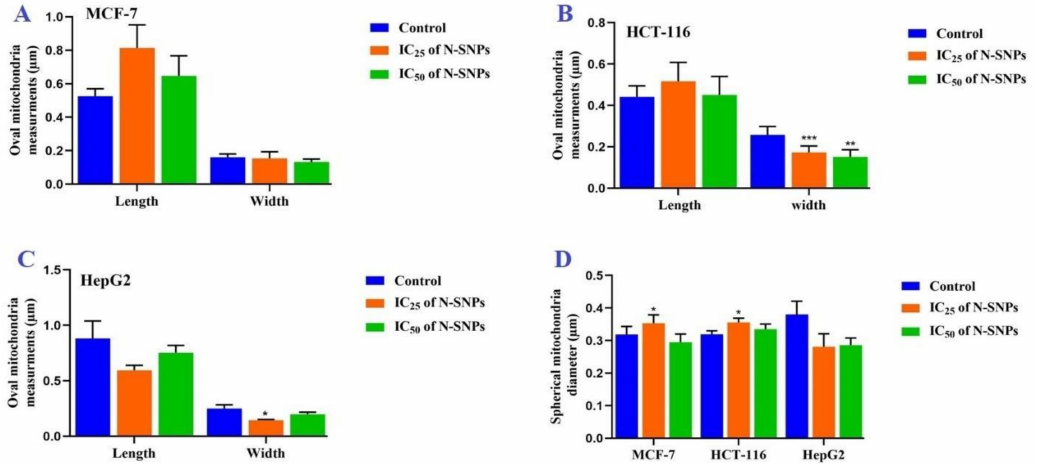
Figure 10. Morphometric analysis ( µ m) of ( A-C ) oval mitochondria dimensions and ( D ) spherical mitochondria diameters in MCF-7, HCT-116, and HepG2 cells before and after treatment with IC25 and IC50 of N-SNPs. Data represent averages of measurements from 10 cells and are presented as mean ± SEM. p -values were calculated versus untreated cells: * p <